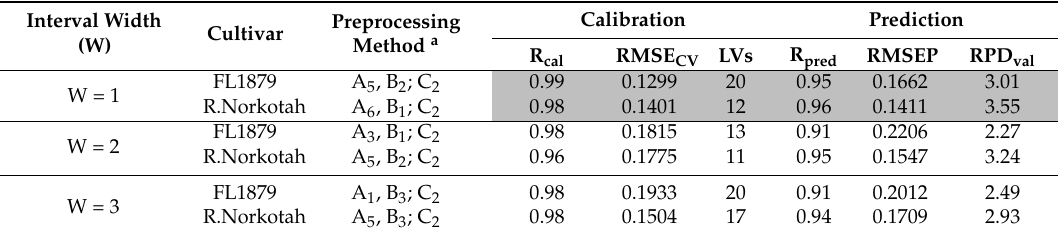
Table 4. PLSR results for predicting primordial leaf count using data fused from VIS/NIR interactance and VIS/NIR hyperspectral imaging systems for whole tubers for Frito Lay 1879 (FL1879) and Russet Norkotah cultivars. Optimal results are shaded. prediction model; RMSE pred : root mean square error of calibration, using cross validation for the prediction model; RPD pred : ratio between standard deviation and the RMSEP pred .